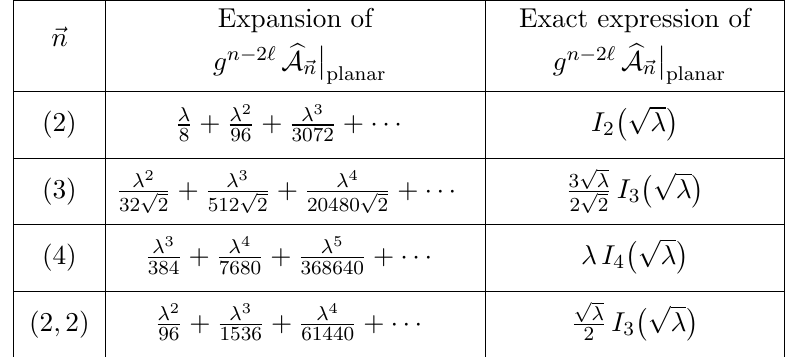
Table 3 . Results for the N = 4 matrix model in the planar limit. As explained in the text, n is the sum of the components of ~n while ‘ is the number of these